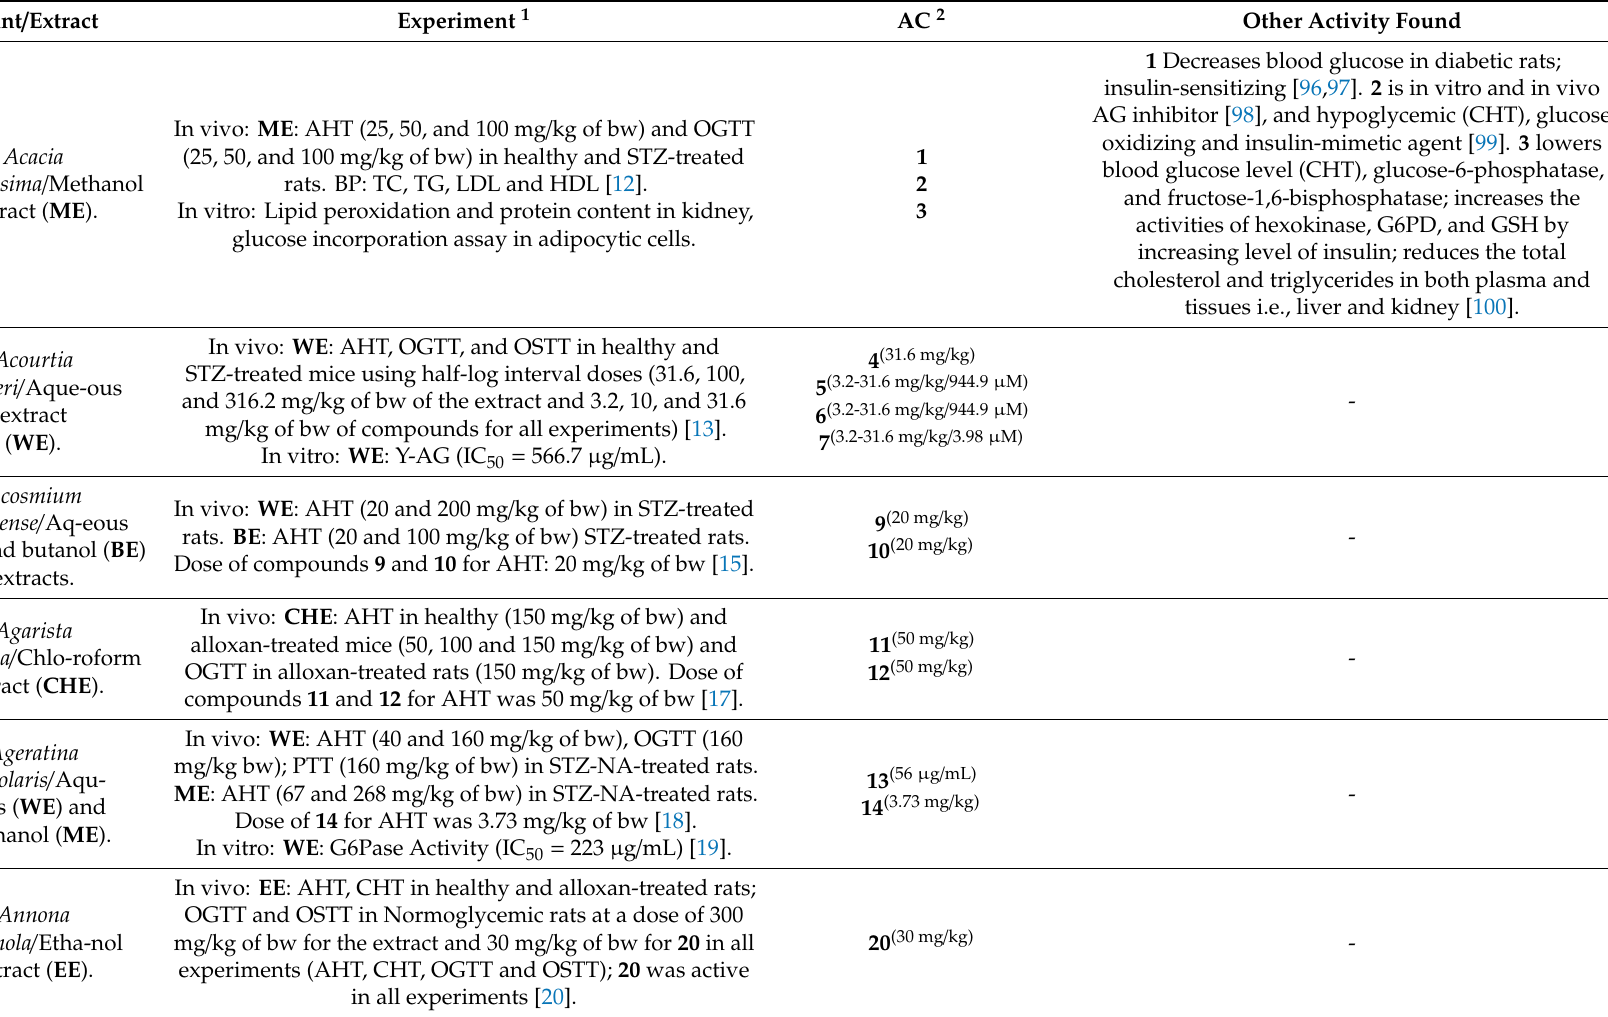
Table 2. Activity Found in the Isolated Compounds from Mexican